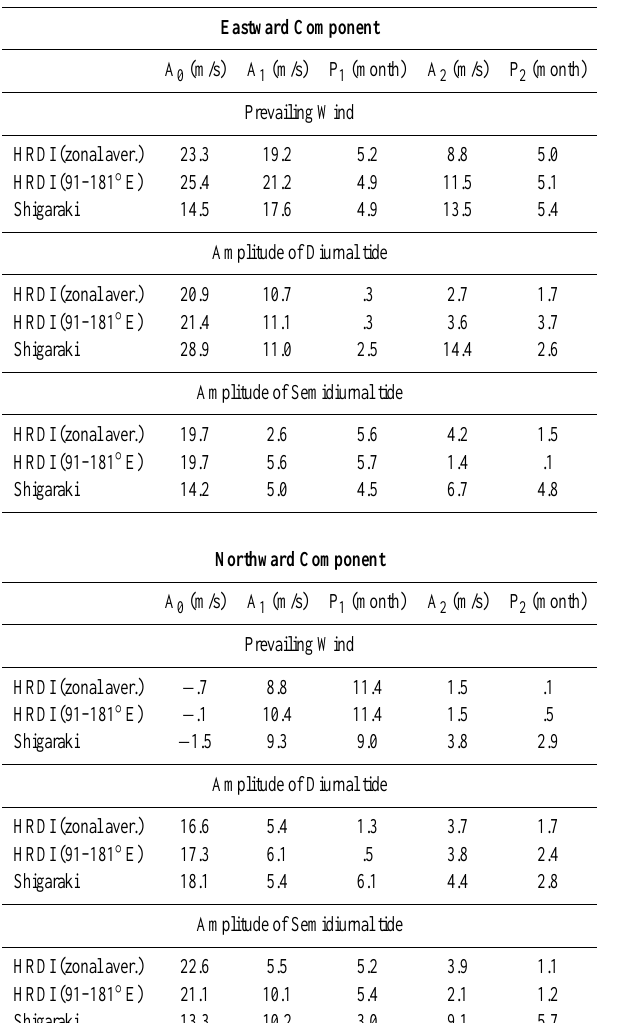
Table 1. Annual mean, annual (A1, P1) and semiannual (A2, P2) harmonics (amplitude, phase) corresponding to the prevailing (di- urnal mean), diurnal and semidiurnal components of the eastward wind (top) and northward wind (bottom) component for 35 ◦ –40 ◦ N.